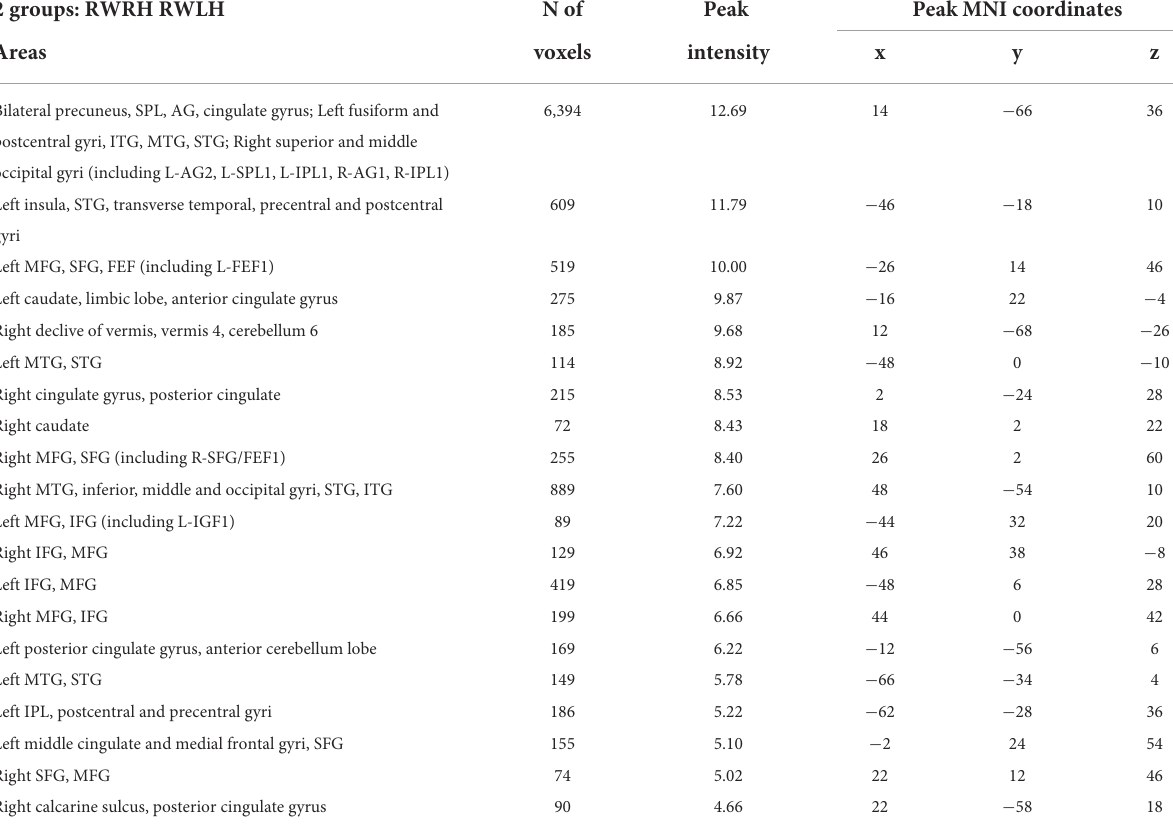
TABLE 4 Brain regions showing significant effects in the interaction between the factors group x session x target location, in the three-way ANOVA including the 2 groups (RWRH, RWLH). 2 groups: RWRH RWLH N of Peak Peak MNI coordinates Areas voxels intensity x y z 6,394